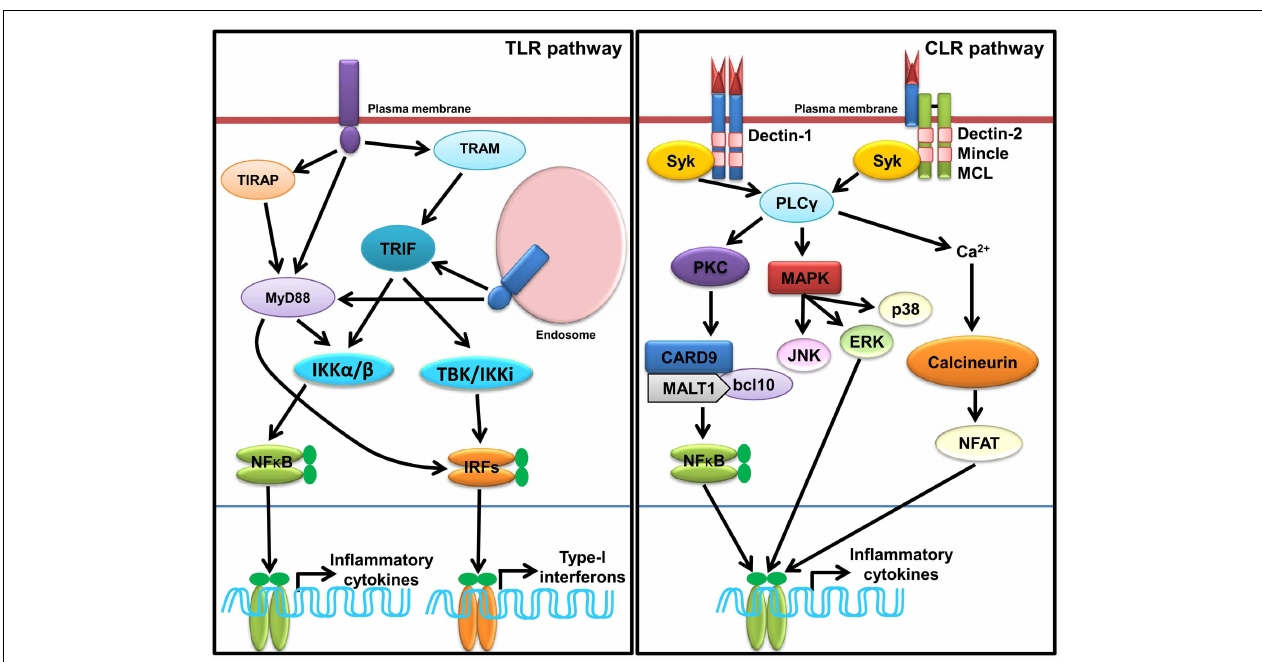
activation of NF- κ B and IRFs (IRF3 and IRF7) via IKK α / β andTBK1/IKK1, respectively. Dectin-1, Dectin-2, Mincle, and MCL are representative CLRs of Dectin-1 and Dectin-2 clusters. Sensing of various SCPs by Dectin-1 and Dectin-2 (shown in Table 1 ) recruits, Syk adaptor which further recruits PLC γ and activate cascade of signaling for induction of inflammatory cytokines via NF- κ B and MAP